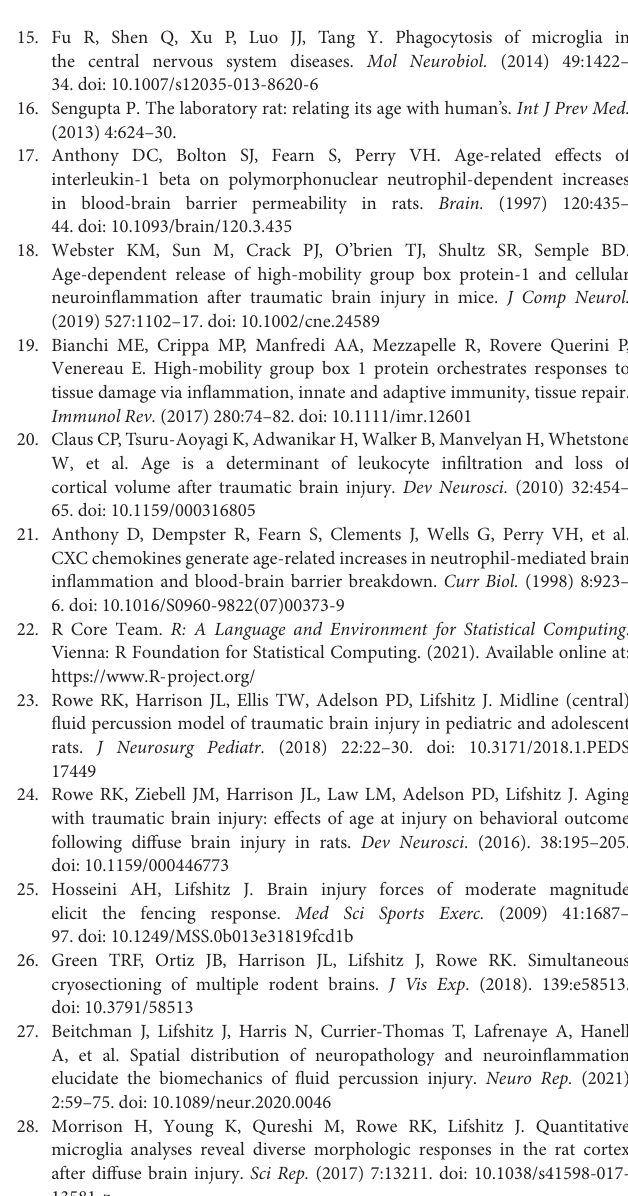
Supplementary Figure 1 | Iba1 stained microglia in the peri-injury cortex at 2h (H), 1 day (D), and 25D post-injury compared to uninjured shams at 7D. All